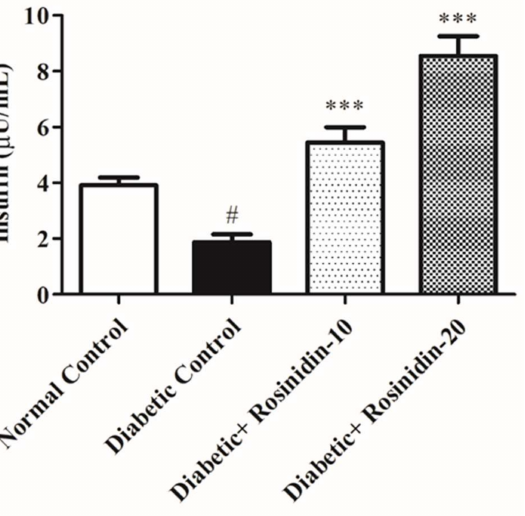
Figure 3. Effect of rosinidin on insulin against that of STZ-induced diabetic rats ( n = 6). Values are expressed as mean ± SEM. # p < 0 .05, normal control vs. diabetic control; *** p < 0 .001, diabetic control vs. rosinidin-10, rosinidin-20.